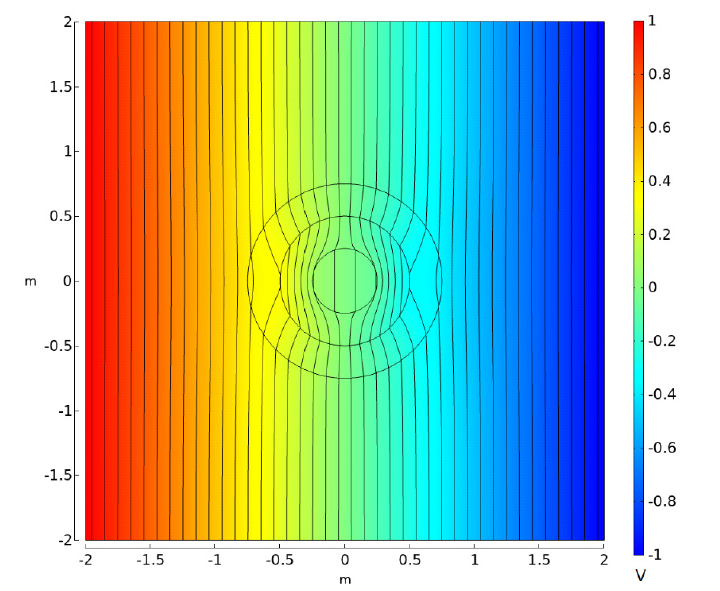
Figure 5. Potential distribution of a structure, where anisotropic multilayer sphere with tangential permittivities ε 1 t = { 8,4,1 } and radial permittivities ε 1 r = { 0.008,0.035,1 } were